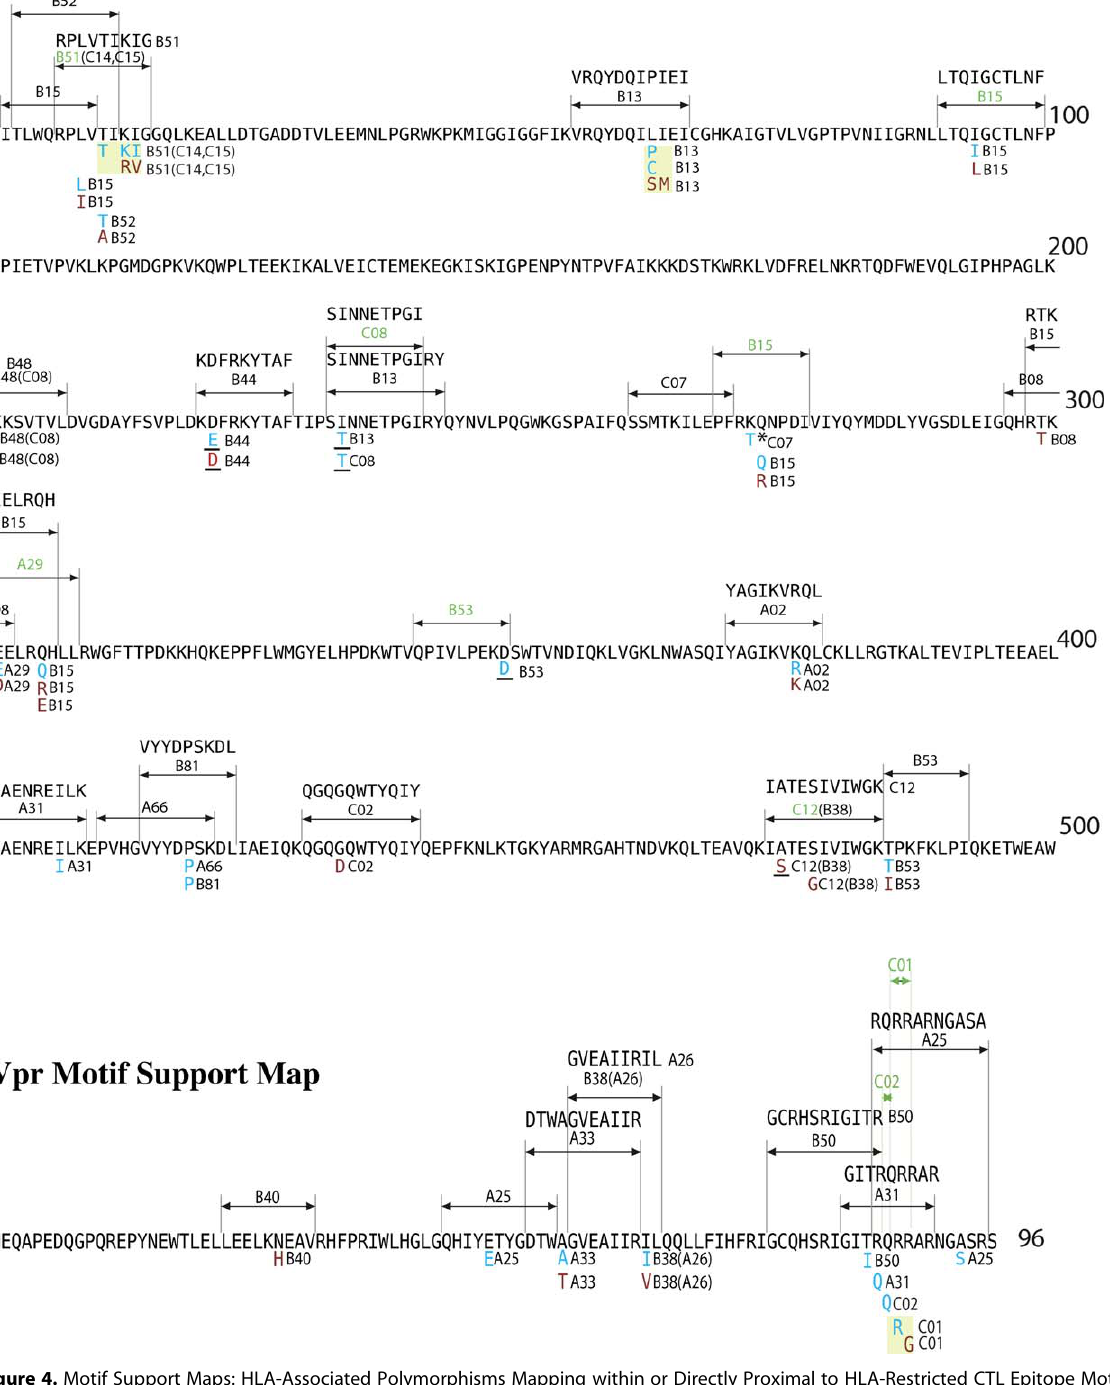
Figure 4. Motif Support Maps: HLA-Associated Polymorphisms Mapping within or Directly Proximal to HLA-Restricted CTL Epitope Motifs in Protease/ Reverse Transcriptase and Vpr HLA-associated polymorphisms occurring within or directly proximal to ( 6 3 aa) known HLA-restricted epitope anchor residue motifs in protease/RT and Vpr are shown. Polymorphisms associated with the same HLA allele(s) occurring within or directly proximal to ( 6 3 aa) of HLA-restricted epitope anchor residue motifs are boxed together in yellow. Predicted epitopes (where available) are indicated above the epitope boundary arrow, while HLA-restricted epitope motif boundaries are simply marked by their corresponding HLA association. Where multiple overlapping motifs were present, only the most commonly observed one (based on analysis of individual sequences) is indicated. Linked alleles are indicated in brackets, and in ranked order based on p-value of the association. Red ( ‘‘ escape ’’ ) amino acids indicate positive correlations (amino acids that are enriched in the presence of a specific HLA allele thus presumably represent escape variants). Blue ( ‘‘ reversion ’’ ) amino acids indicate negative correlations, where the presence of a specific HLA allele is associated with the absence of a particular amino acid at a specific position—and vice versa—in this case, the amino acid presumably reflects the immunologically susceptible form specific for that HLA allele. Underlined associations indicate potential HLA anchor residue sites. Proximal associations (within 6 3 aa of epitope boundaries) are marked with an asterisk (*). Associations supported by functional IFN- c (ELISpot) data are indicated in green. Where an association is supported solely by ELISpot data, but no predicted epitope or motif, the arrow and lines are all green.